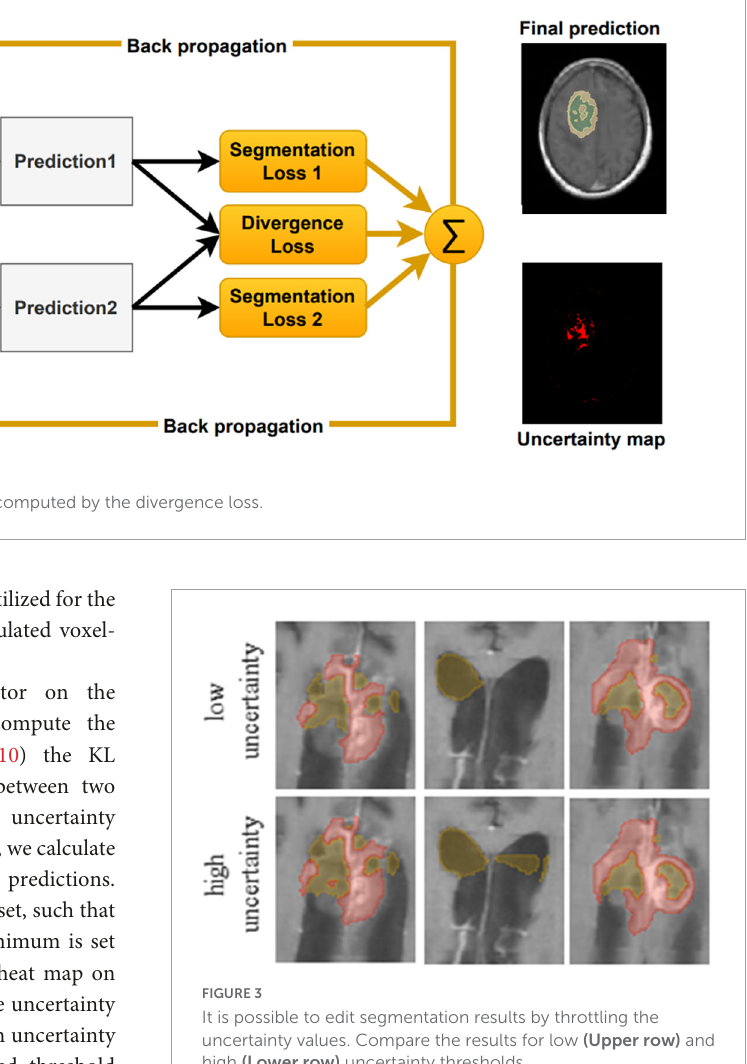
FIGURE3 It is possible to edit segmentation results by throttling the uncertainty values. Compare the results for low (Upper row) and high (Lower row) uncertainty